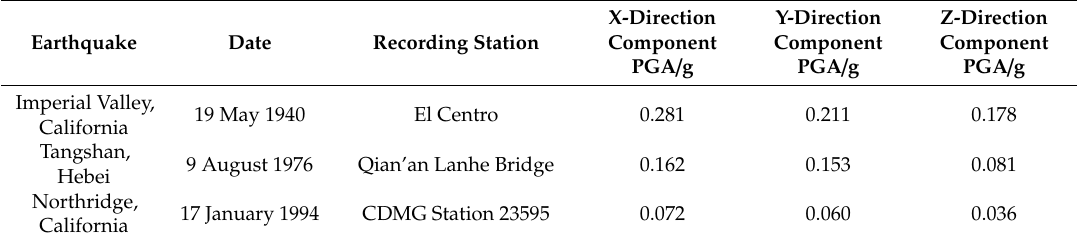
Table 2. Characteristics of the earthquake ground